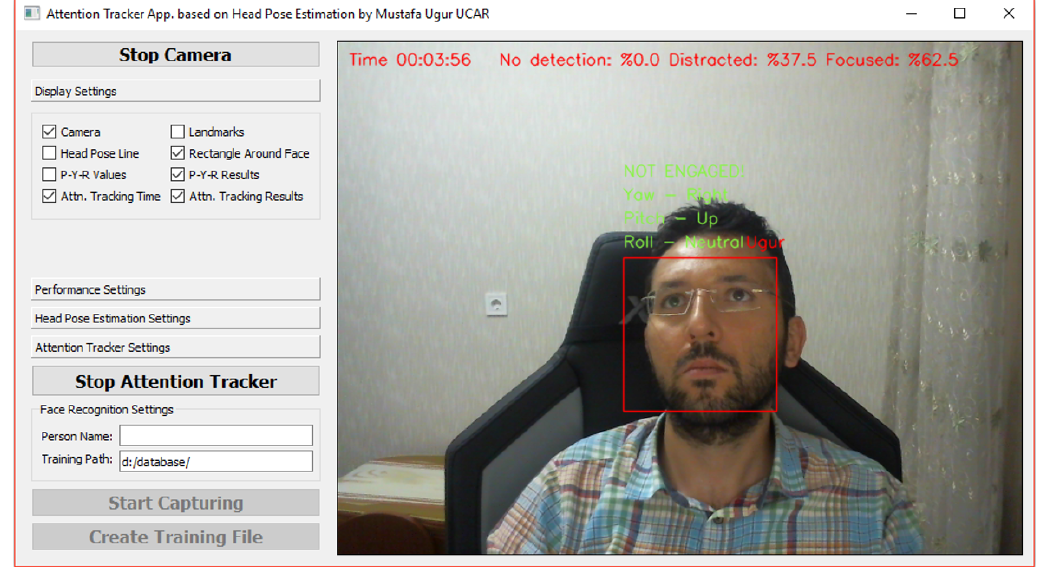
Figure 12. SECS main module—instant total distraction results.